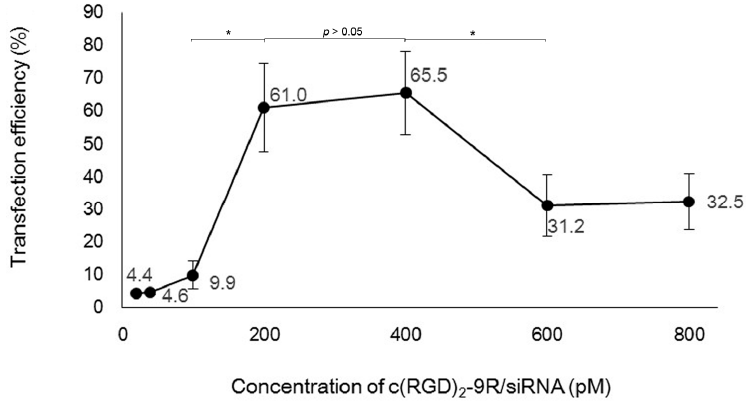
Figure 3. Transfection efficiency of siRNA delivery mediated by c(RGD) 2 -9R at different concentrations. * represented p < 0.05.